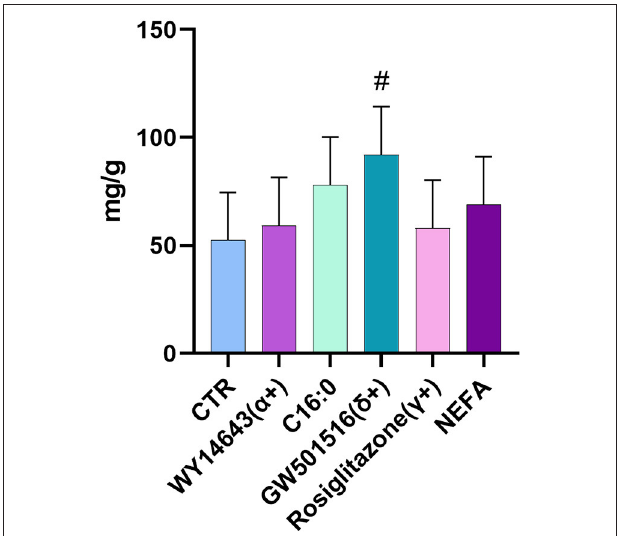
FIGURE 2 | Amount of triacylglycerol in PCLS from postpartum cows ( + 10 DIM) treated with PPAR isotype-specific agonists (100 µ M WY-14643, a PPAR α agonist; 50 µ M GW-501516, a PPAR δ agonist; and 100 µ M Rosiglitazone, a PPAR γ agonist), 200 µ M palmitic acid, or 100 µ M NEFA isolated from each respective animal. Results are presented as fold change vs. each animal’s control group (PCLS cultured in William’s Medium E only). # indicates tendencies ( P < 0.1) when compared to control. Incubation time was 18h.